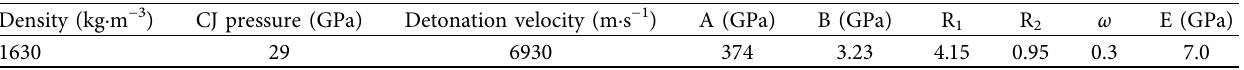
Table 3: The explosive and its state equation parameters.